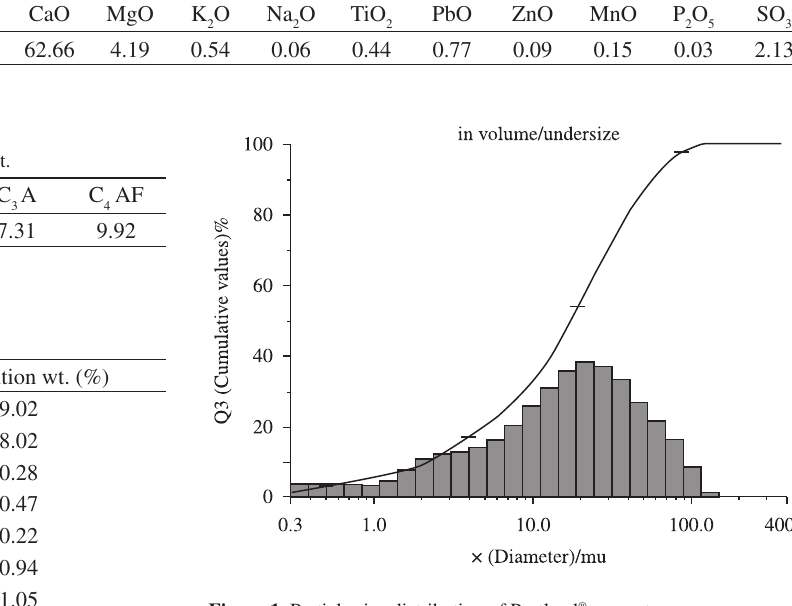
Figure 1. Particle size distribution of Portland ®